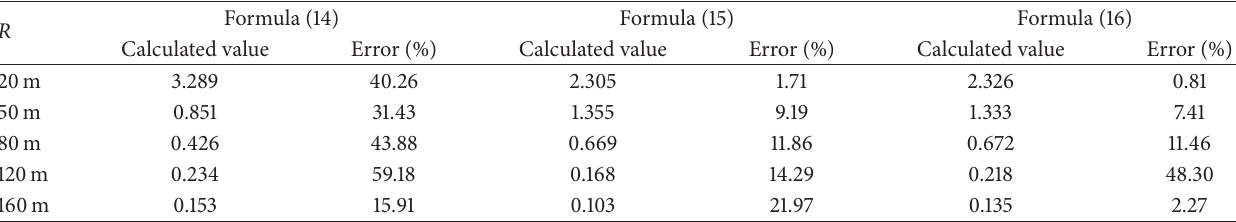
Table 2: Comparison of calculated value and experimental value of three fitting formulas (cm/s).